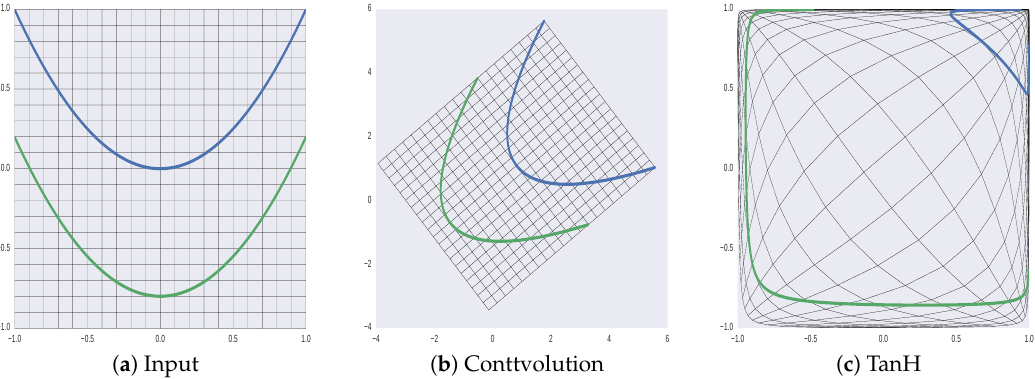
Figure 1. Behaviour of convolution and TanH layers. Here, two curves ( a ), which cannot be linearly separated, are fed into a standard CNN; the input undergoes different types of transformations in convolution and TanH layers. ( b ) and ( c ) display the output of convolution and TanH layers,